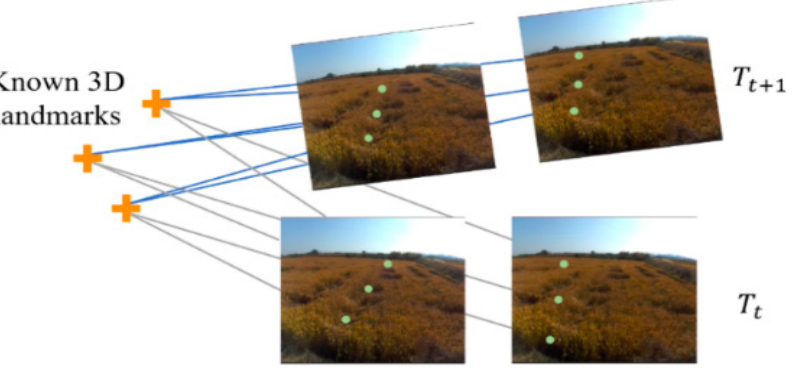
Figure 3. 3D–2D correspondence; the crosses denote a sparse set of landmarks, the green dots represent their corresponding 2D projections in the image. T t and T t + 1 denote the pose at time t and t +1, respectively.